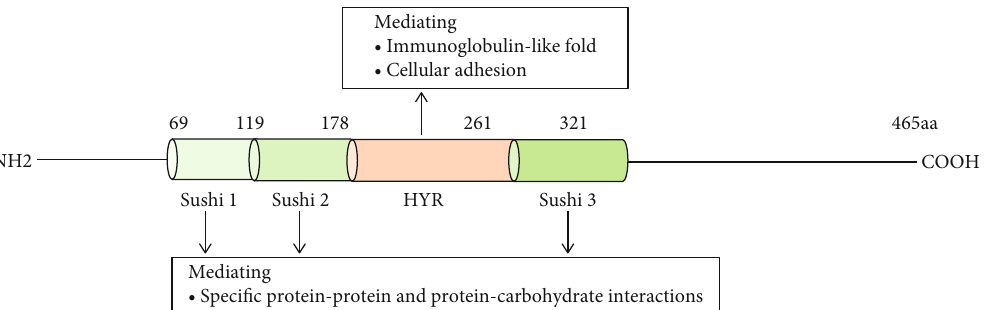
Figure 1: Schematic structure of SRPX2 protein. Sushi: sushi domain; sushi 1: 69-119AA; sushi 2: 120-178AA; sushi 3: 262-321AA; HYR: hyaline domain, 177-261AA; AA: amino